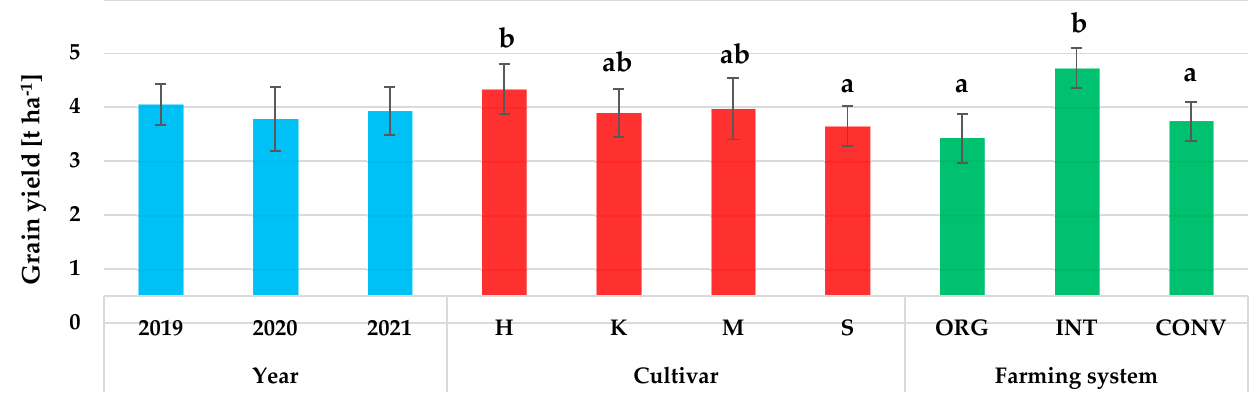
Figure 1. The effect of year, cultivar, and farming system on grain yield (GY). Different letters correspond to significant differences ( α = 0.05) between means according to Tukey’s test. Error bars indicate the standard error of the mean. Abbreviations: H—Harenda, K—Kandela, M—Mandaryna, S—Serenada, ORG—organic, INT—integrated, and CONV—conventional.